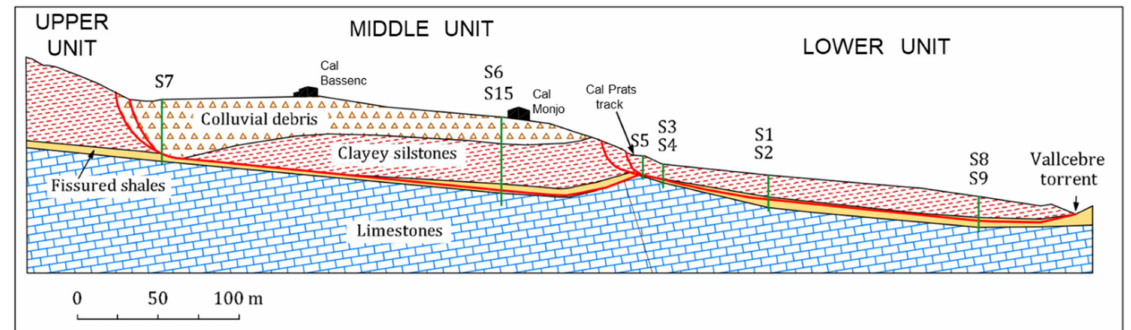
Figure 10. NE-SW geological cross-section of the Vallcebre landslide according to [1,2]. Some of the 17 boreholes drilled are shown, which were equipped with inclinometers, wire extensometers (for shear displacement) and vibrating wire piezometers.